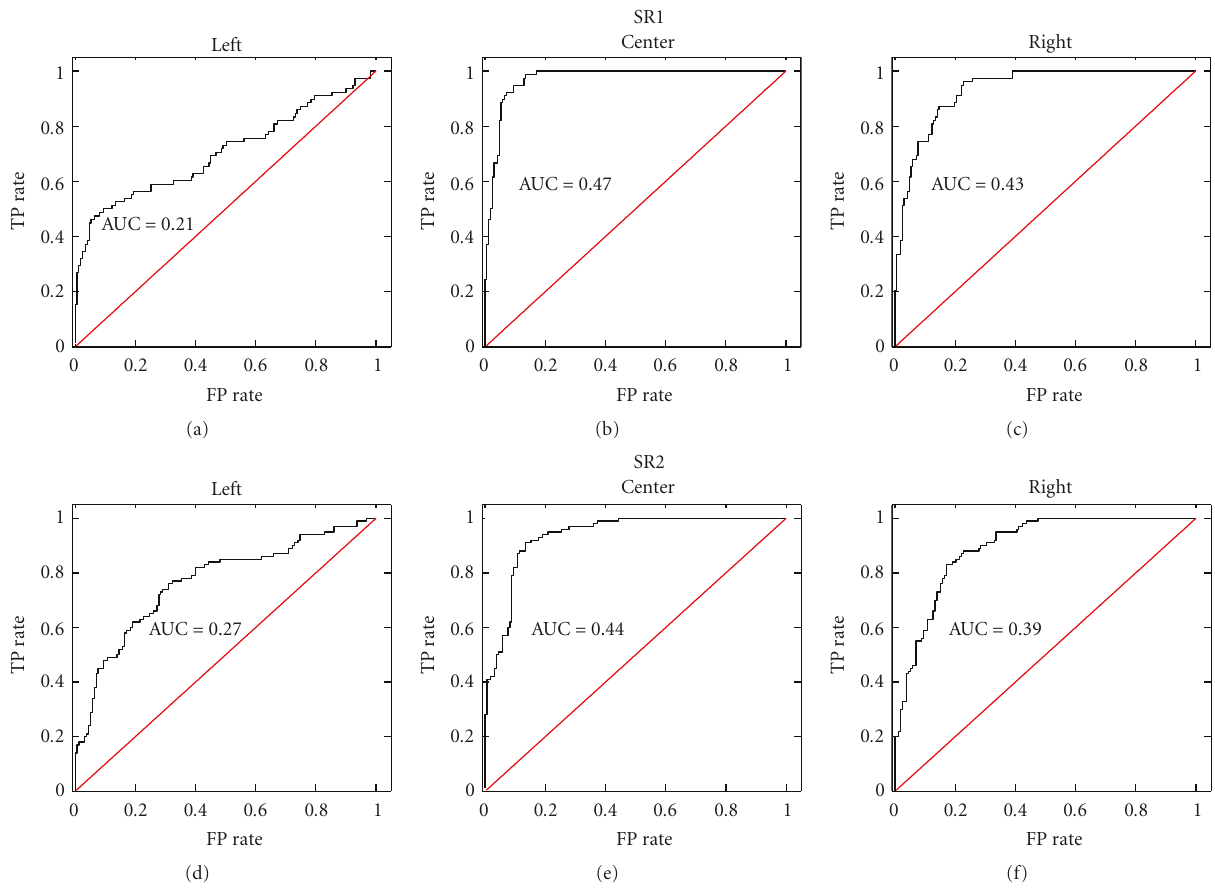
Figure 9: The ROC curves related to the model order p = 6 computed on the training data in the left, center, and right windows. Note that the discrimination in the center and right windows is better than the left